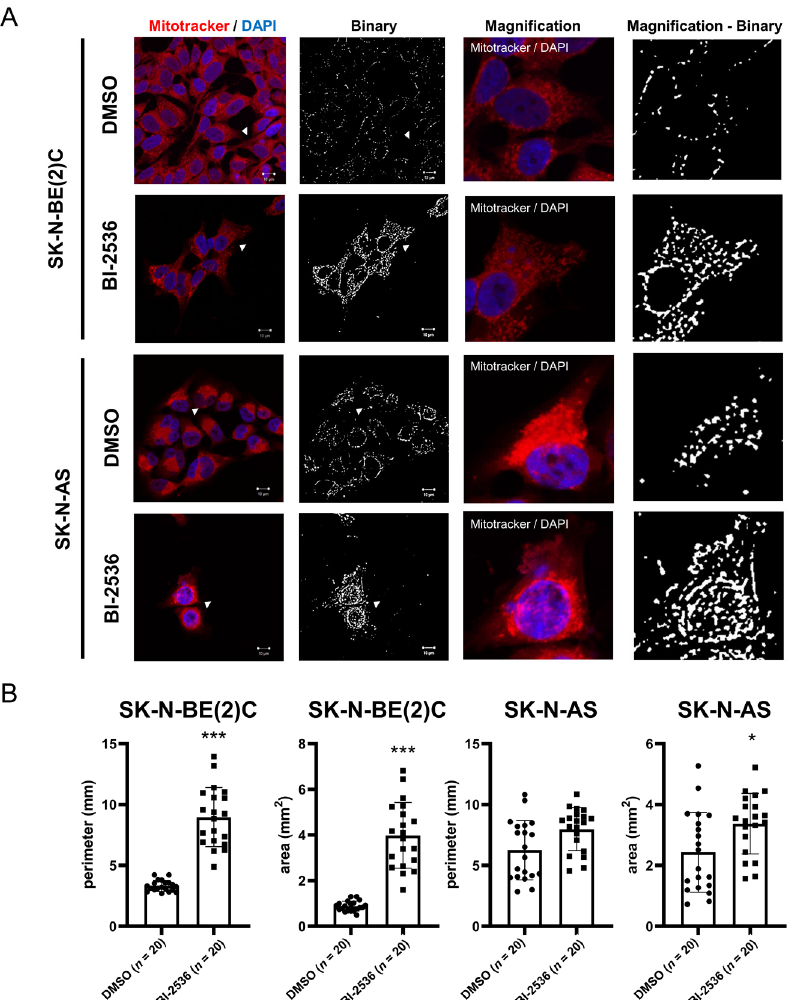
Figure 6. Immunocytochemistry showing mitochondrial dynamics after treatment of neuroblas- toma cells with BI-2536 for 24 h: ( A ) The nucleus and mitochondria were stained using 4 ′ ,6-diamidino-2-phenylindole (DAPI) and MitoTracker ® (Thermo Fisher Scientific). Transformation to binary photography was performed using ICY ver. 2.1.0.0 software (http://icy.bioimageanalysis.org/; (accessed on 21 March 2021)). The mitochondrial perimeters and areas significantly increased after treatment, indicating that mitochondria in SK-N-BE (2) C and SK-N-AS cells fused and elongated after treatment with BI-2536 for 24 h. ( B ) Quantified data from the immunocytochemistry analysis. * p < 0.05, *** p < 0.001 from two-tailed unpaired Student’s t -test to determine whether the mean value of a given group is equal to the corresponding DMSO alone group.